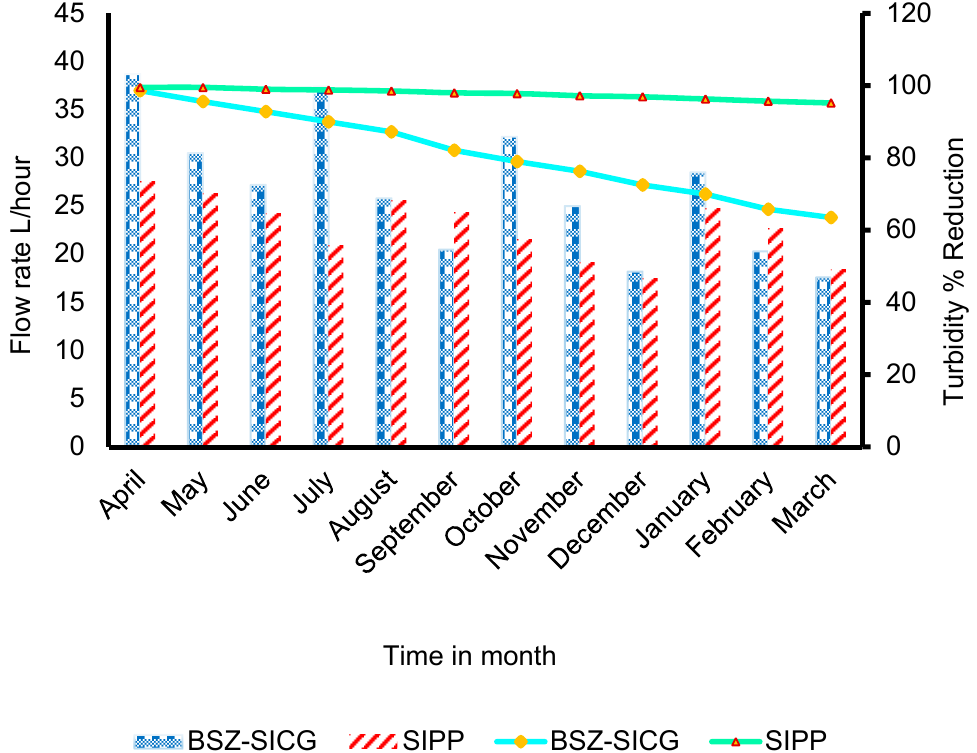
Figure 5. The arithmetic mean turbidity reduction (%) and flow rate in L / hour of the BSZ-SICG and SIPP filters versus time in months. Table 6. The arithmetic mean results of the influent and effluent turbidity during the study period.